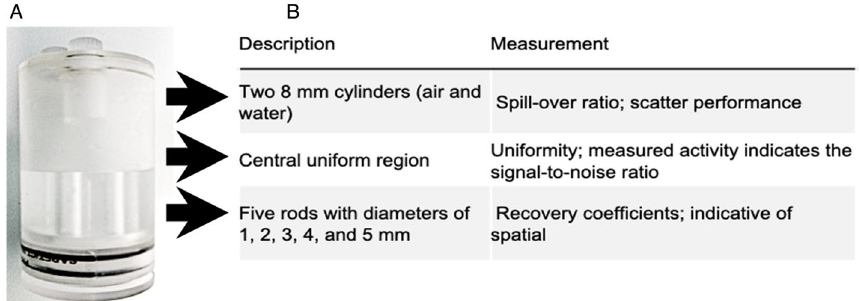
Fig. 6 Three-chambered PET preclinical image quality phantom (IQ) (6.3 displays an image of the IQ phantom. Panel B outlines the individual chambers/sections of the phantom